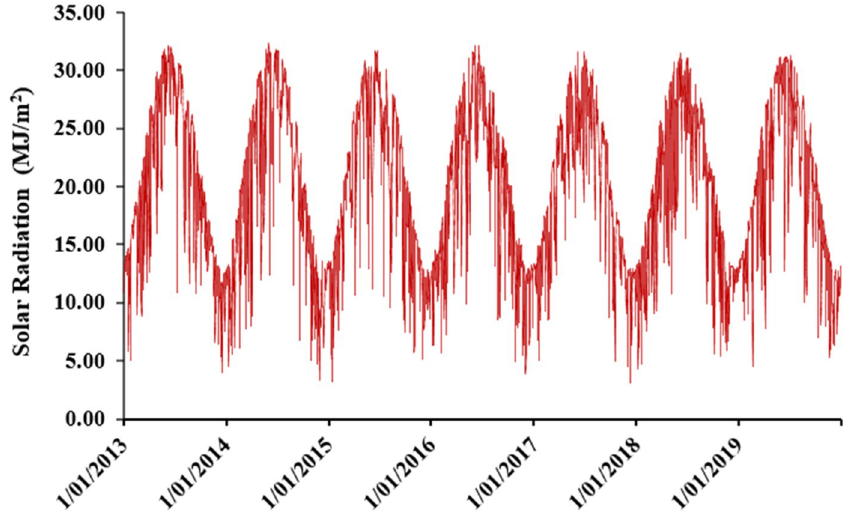
Figure 5. The evolution of solar radiation over 7 years’ time horizon